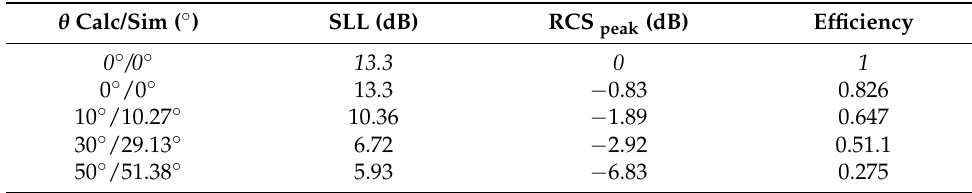
Table 3. Parameters for steering angles θ at 13.5